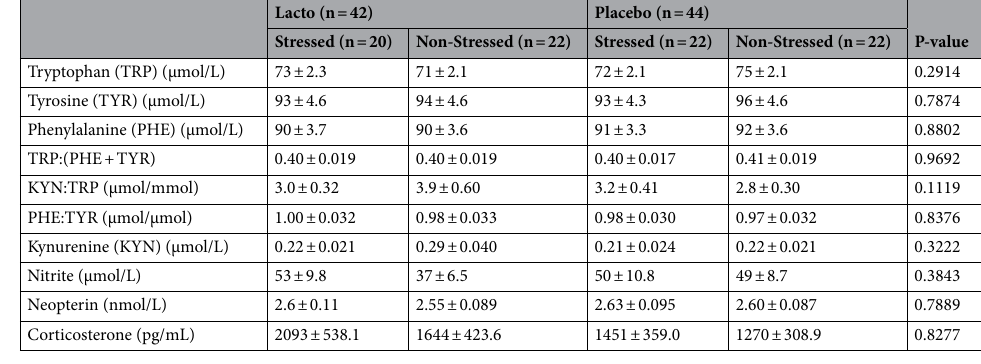
Table 1. Least Squares Means (± Standard Error) of amino acid, immune biomarker and corticosterone concentrations in laying hens (n: S-Placebo = 22, NS-Placebo = 22, S-Lacto = 20, NS-Lacto = 22) after 8 weeks of treatment based on supplementation (Lacto: L. rhamnosus , Placebo: Placebo supplementation) and stress (stressed, non-stressed). No statistically significant difference was found due to the stress treatment, L. rhamnosus supplementation or their interaction (P-value shown refers to the interaction).